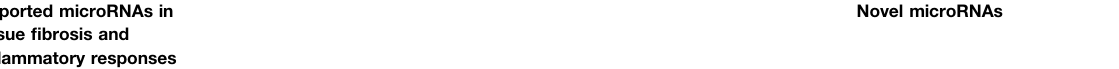
TABLE 1 | Lists of microRNAs present in exosomes derived from human corneal stromal cells that function to reduce corneal